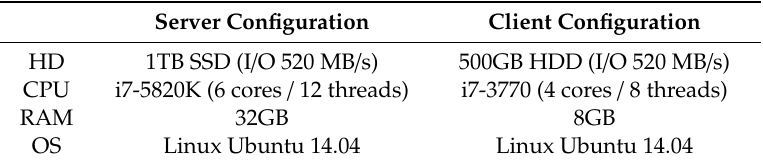
Table 1. Hardware configuration for the load testing